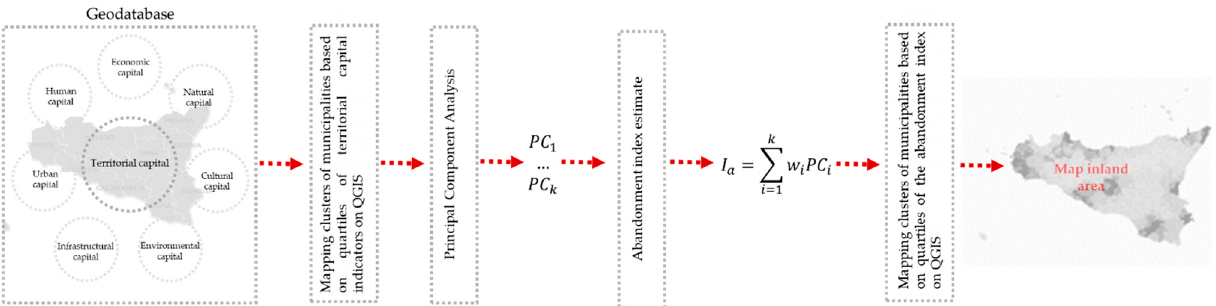
Figure 8. Flowchart of the methodological approach.